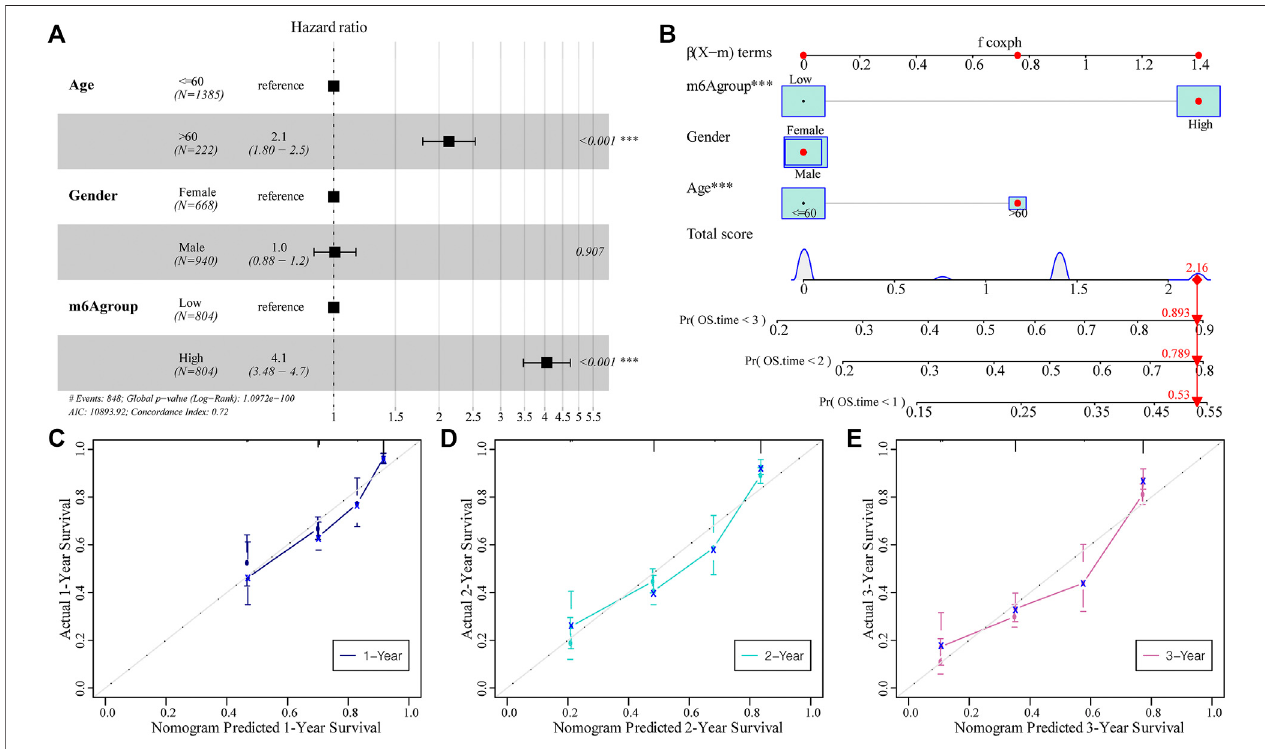
FIGURE 9 | The predictive ability of the m6A risk score on glioma patient prognosis. (A) Multivariate Cox regression analysis of risk score combined with clinicopathological characteristics of HR and p -values; analysis showed that the m6A group score is an independent risk factor for the prognosis of glioma patients; (B) The m6A group score combined with clinicopathological characteristics was selected to construct a clinical prediction model; (C – E) The calibration curve of the nomogram; the x -axis is the survival predicted by the nomogram, while the y -axis is the survival actually observed. The curve shows that the model has a good predictive value for one-, two-, and 3-year predictions.